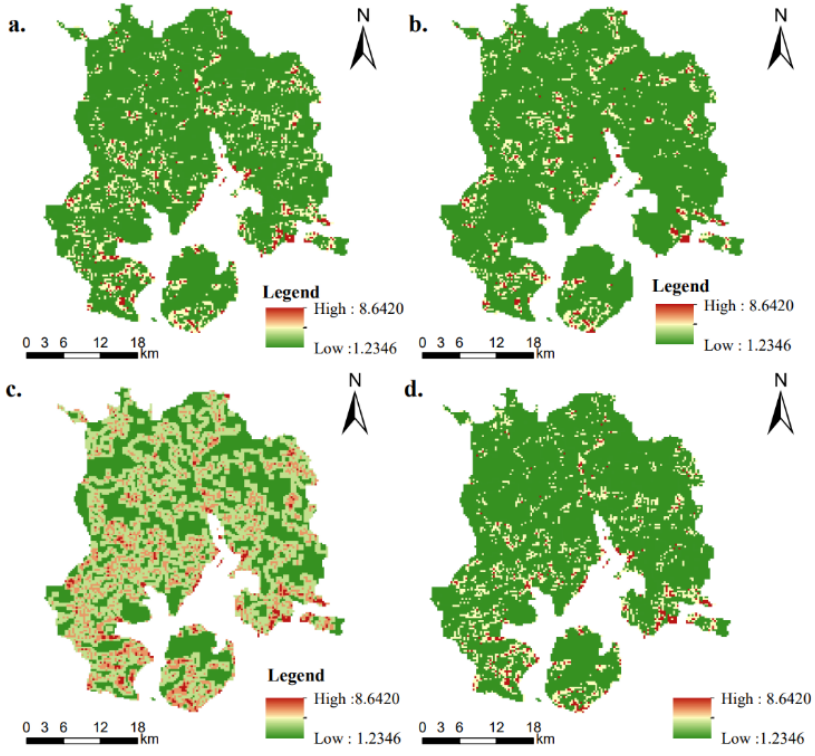
Figure 7. Land use stability index distribution in 2020 and 2030: ( a ) 2020; ( b ) NDS; ( c ) PIS; and ( d ) SDS.